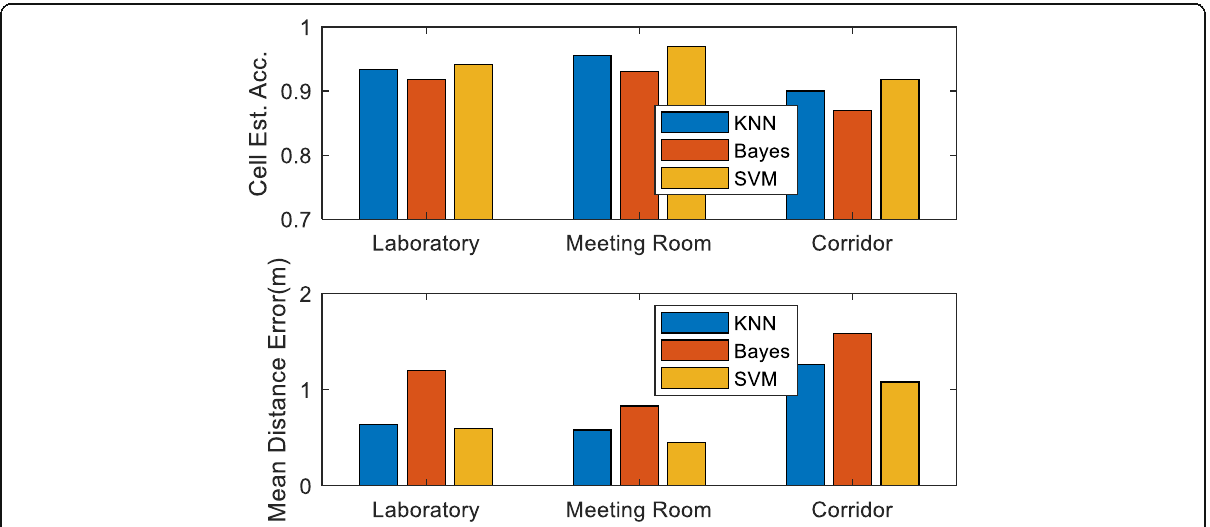
Fig. 7 Cell estimation accuracy and median distance error in three scenarios. In the top figure blue, orange and yellow bar represent the cell estimation accuracy for using KNN, Bayes, and SVM as the match algorithm in the laboratory and meeting room, respectively. In the bottom figure, blue, orange, and yellow bar represent the median distance error for using KNN, Bayes, and SVM as the match algorithm in the laboratory, in the meeting room and in the corridor,